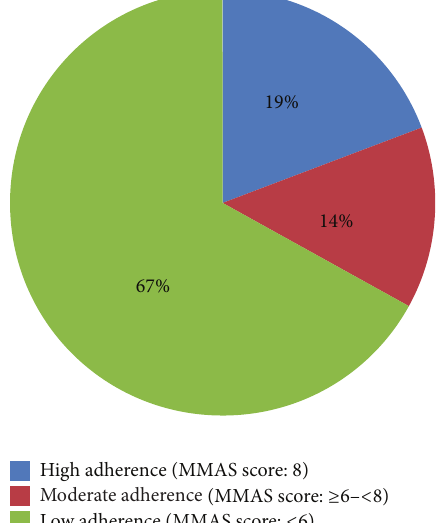
Figure 1: Hospital-based prevalence of adherence ( 𝑁 = 239